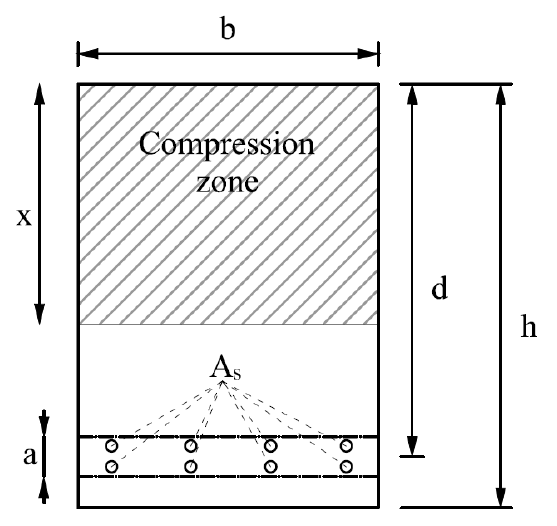
Figure 3. Geometrical parameters used in equation (4).